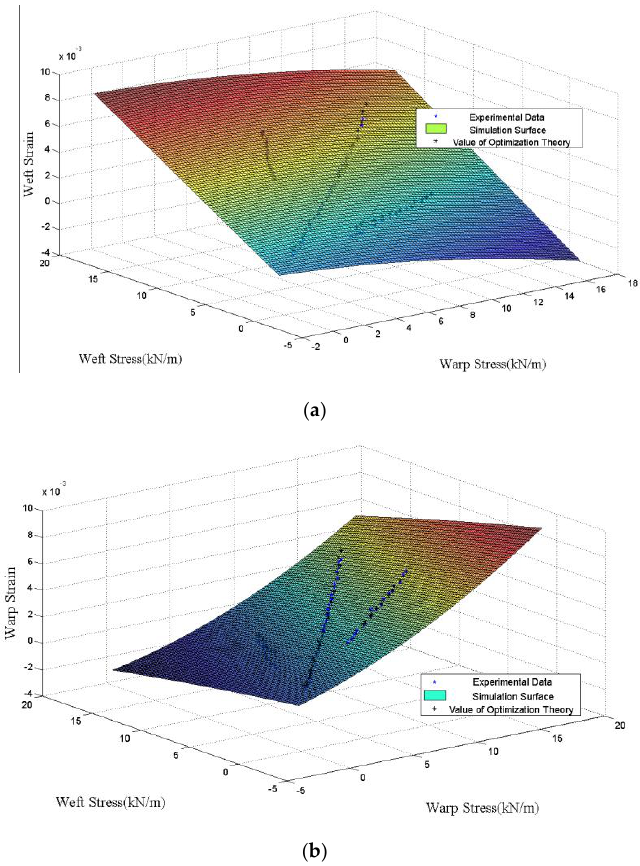
Figure 13. Comparison of the three different types of data. ( a ) Warp Strain. ( b ) Weft